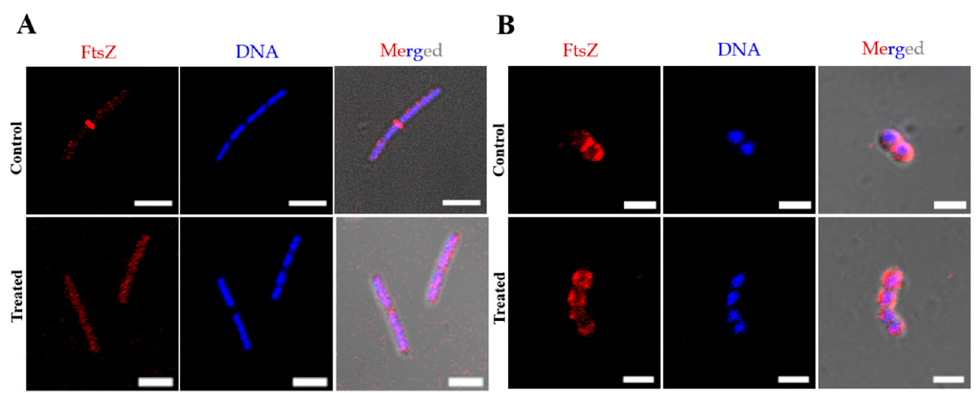
Figure 4. Enol 3 causes Z-ring delocalization in B. subtilis and S. pneumoniae without affecting the DNA segregation. Fluorescence (Alexa Fluor 594 and DAPI channels for FtsZ and DNA, respectively) and DIC-merged laser scanning confocal microscopy images of fixed cells. ( A ) B. subtilis 168